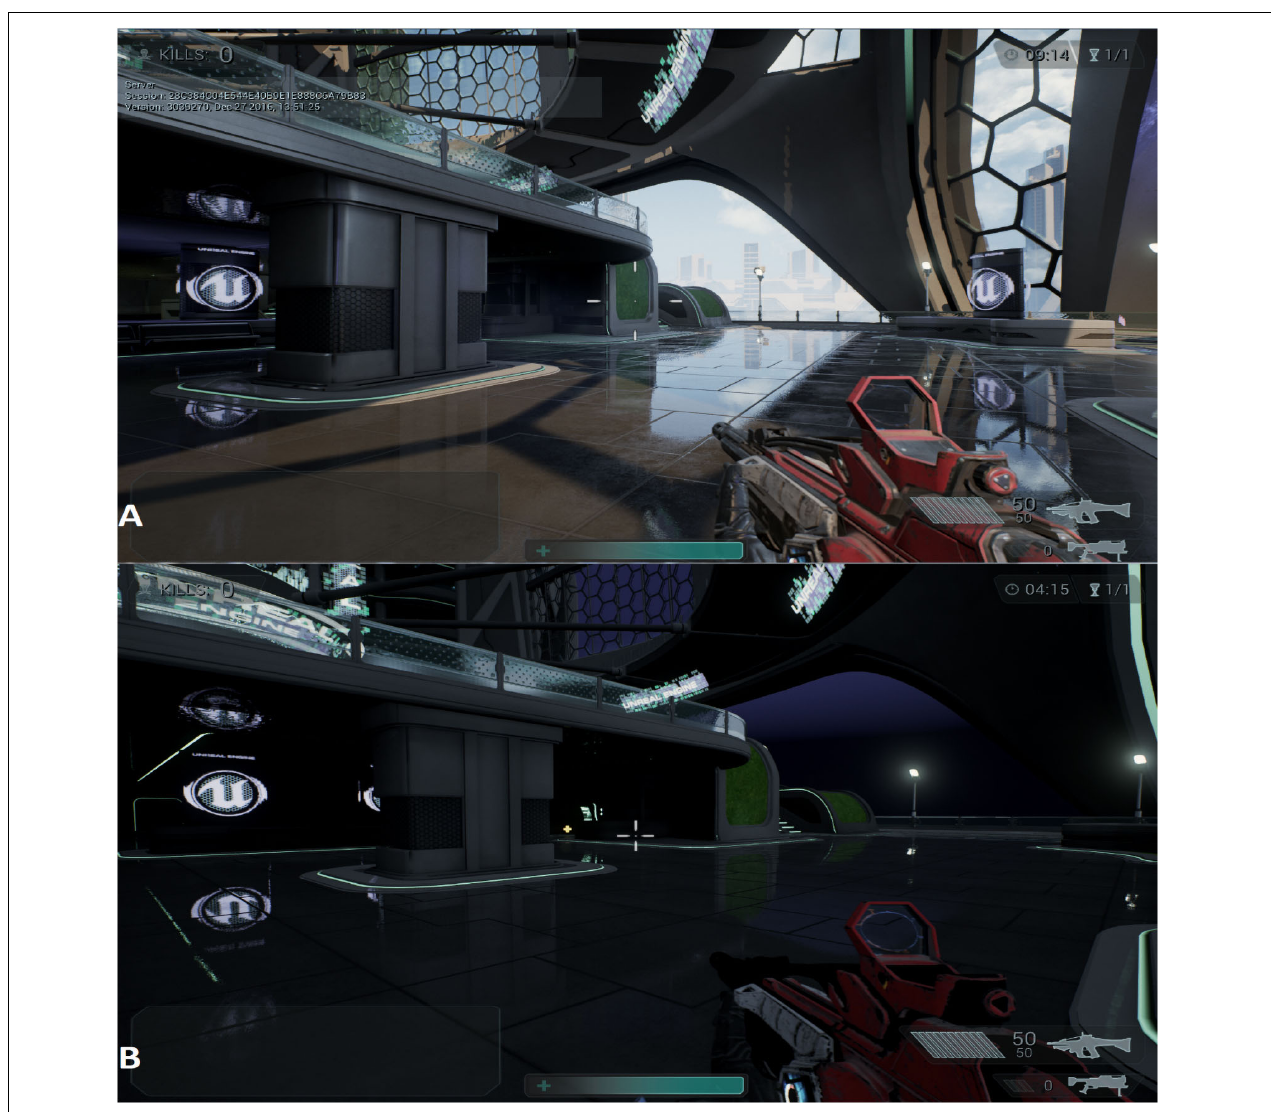
FIGURE 2 | Modified version of the “Shooter Game” using visibility as the NF modality. (A) The maximum luminosity condition and running crosshair bars are illustrated, whereas in (B) the luminosity is set to minimum, and the crosshair bars while the player character is stationary are